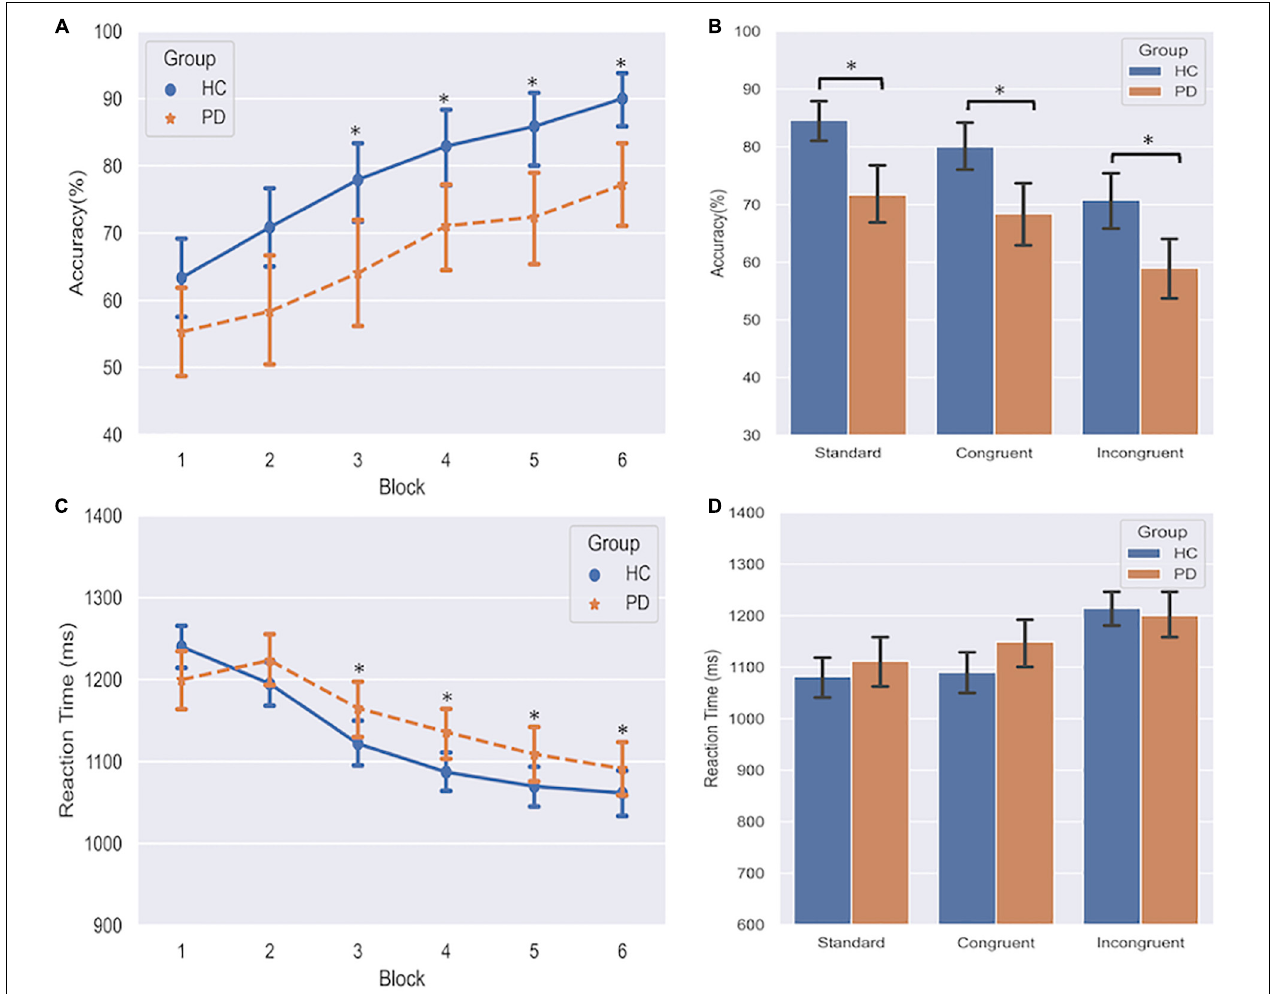
FIGURE 2 | Effects of PD on instrumental learning. (A) Response accuracy of PD and HC group over six blocks. *indicates p < 0.05 compared to Block 1. (B) Response accuracy across acquisition of standard, congruent, and incongruent associations. *indicates p < 0.05 in the comparison between PD and HC. (C) Reaction time of PD and HC group over six blocks. *indicates p < 0.05 compared to Block 1. (D) Reaction time across three associations. Error bars denote standard